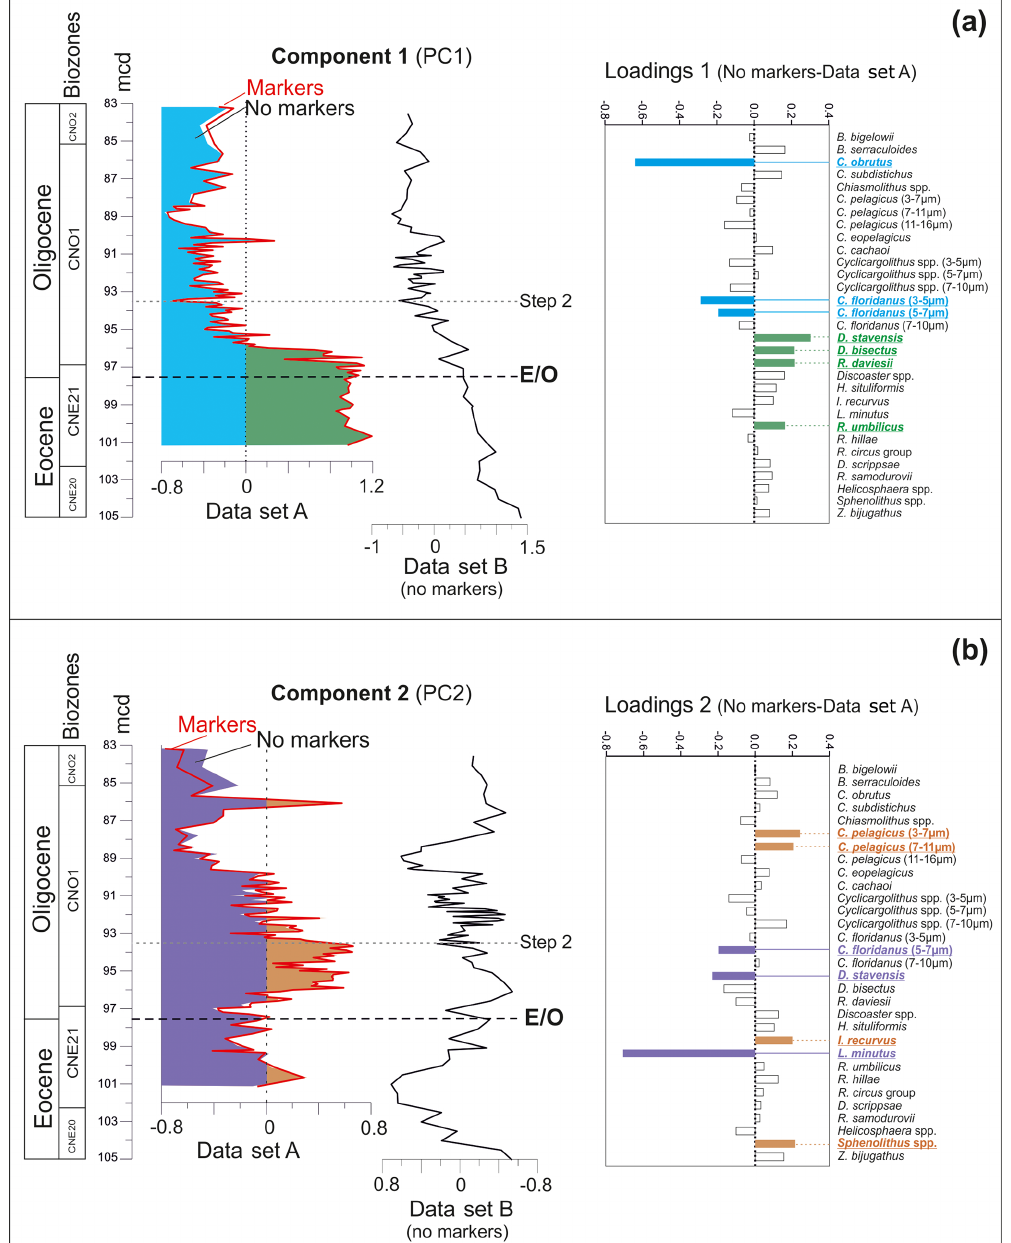
Figure 4. Distribution patterns of PC1 (a) and PC2 (b) obtained from the PCA for the data sets A and B. Loadings of calcareous nannofossil taxa on the two principal components of the whole studied succession for data set A are reported. The shaded boxes represent the most relevant loaded species. Shaded area: PCs (data set A) obtained omitting the marker species in the data set. Red line: PCs (data set A) obtained inserting also the marker species. The positions of EOB and Step 2 are